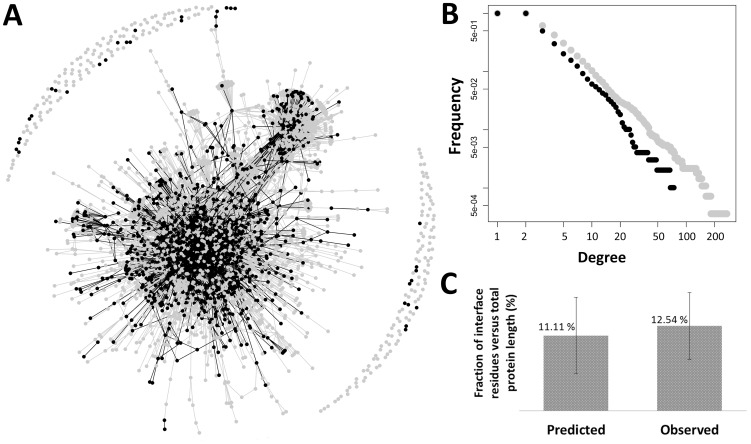
Overall description of the predicted binding sites in the Arabidopsis interactome.(A) Network representation of the Arabidopsis interactome and predicted interaction sites. The vertices and edges in black represent, respectively, the 985 proteins and the 1498 interactions to which predicted motifs are mapped. (B) Degree distributions from the complete protein-protein interaction dataset (grey) and from the subset with only proteins and interactions that have a predicted motif (black). A and B suggest that our method is not biased to predict motifs that can be mapped only to proteins with high degree (i.e. number of interactions); moreover, the proteins with predicted motifs are distributed in different positions in the network. (C) Percentage of residues in the interfaces, either in the predicted interfaces or those observed in the structurally mapped dataset. Standard deviation is indicated.